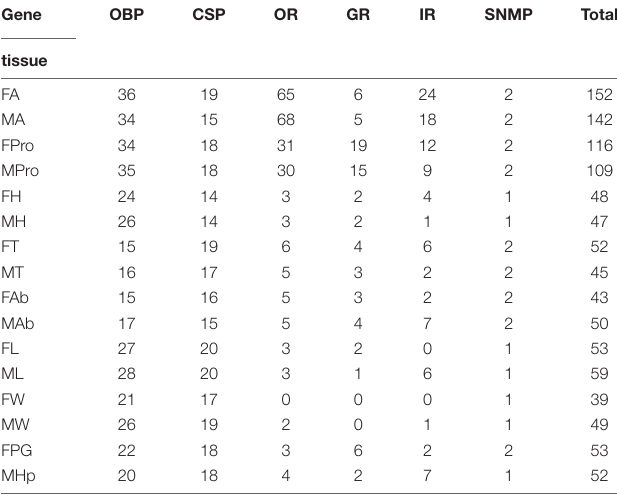
TABLE 2 | Summary of chemosensory genes expressed in various tissues of D. abietella (FPKM > 1 or RT–PCR and qPCR support). Gene OBP CSP